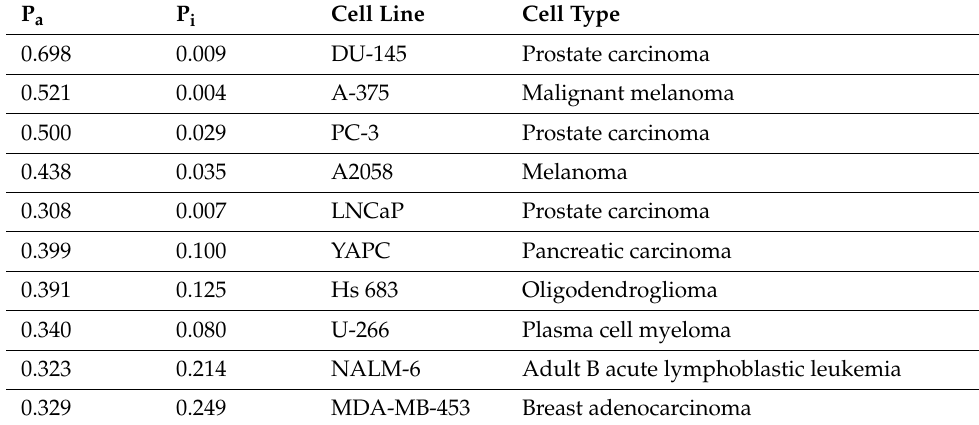
Table 5. Results of for the prediction of cytotoxicity of compound 9a